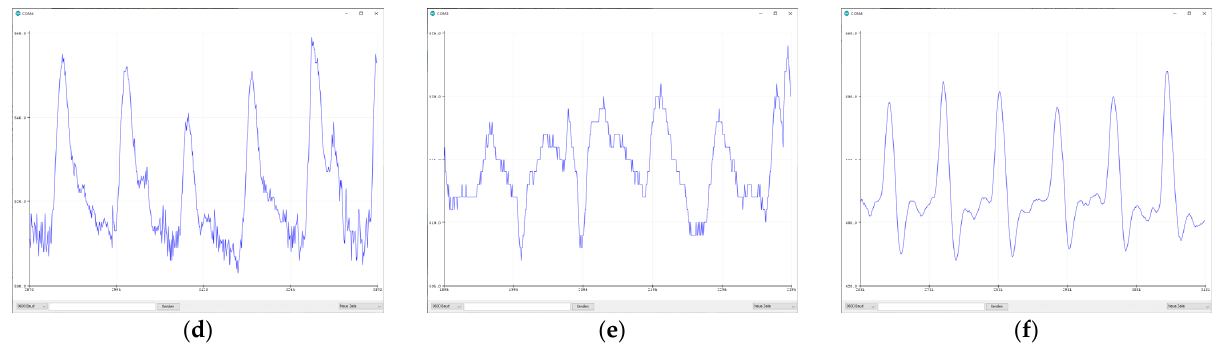
Figure 4. Pulse measurements of proband B, left little finger, with a sensor from ( a ) Berrybase (y-scale 501–513); ( b ) Iduino (490–540); ( c ) Iduino (508–520); ( d ) Keyestudio (500–560); ( e ) Joy-it (505–525); ( f ) Joy-it (420–660).